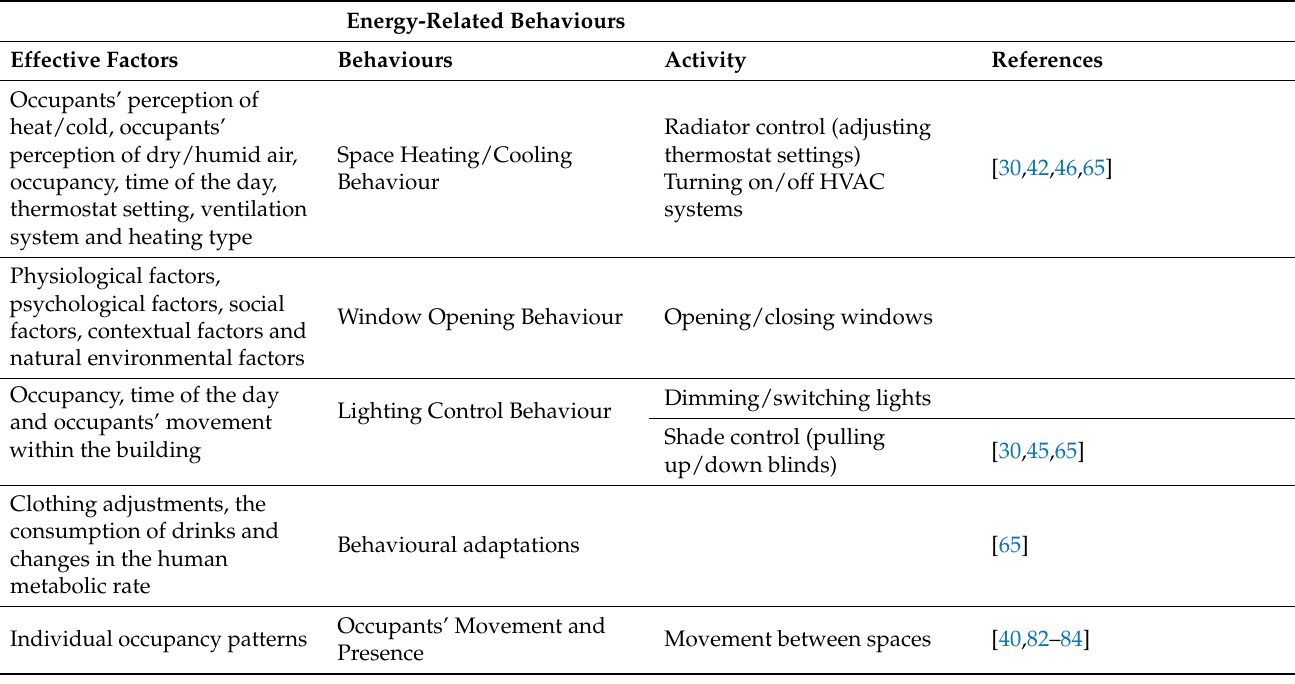
Figure 2. The conceptual framework of occupant energy-related behaviours [40, 42, 45, 46, 81]. Table 4. Energy-related behaviours of the occupants in residential buildings.